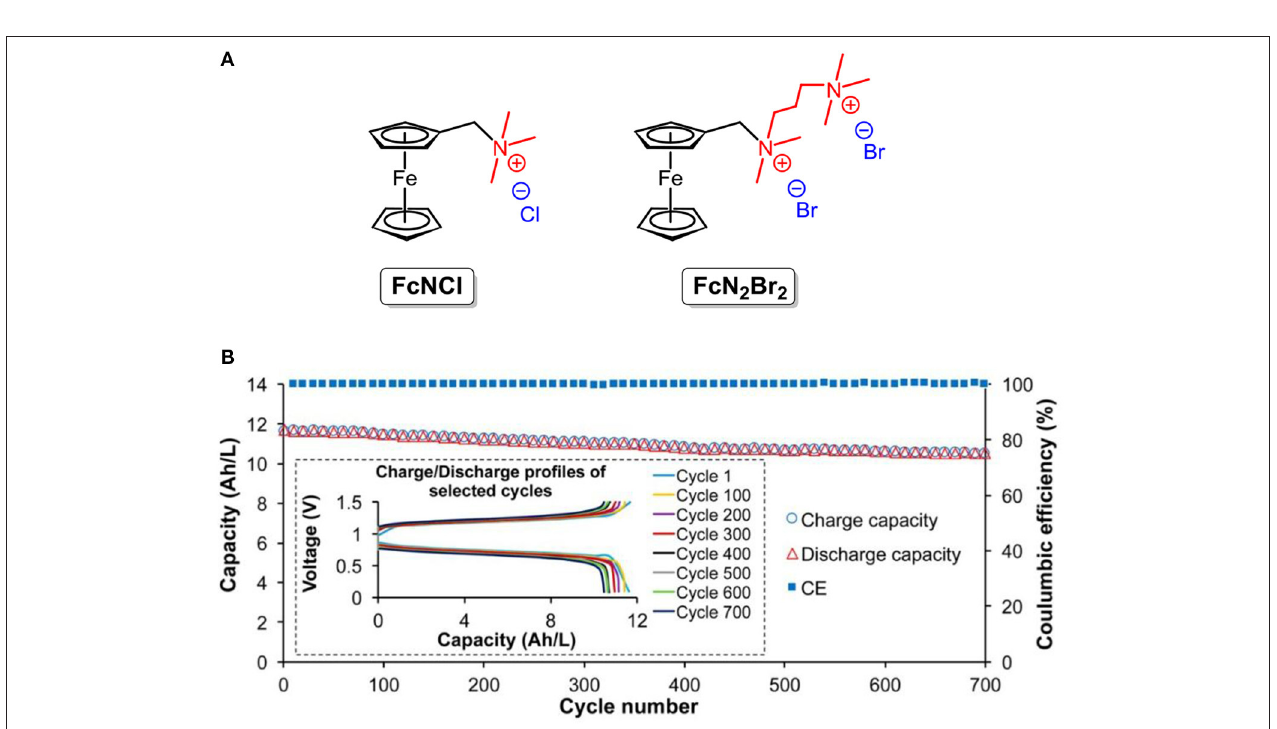
FIGURE 9 | (A) Molecular structures of FcNCl and FcN 2 Br 2 . (B) Extended 700 cycle testing data of the 0.5M FcNCl / MV aqueous RFB at 60 mA/cm 2 : capacity and coulombic efficiency vs. cycling numbers (for clarity, data points with an increment of 10 cycles were used for plotting) (inset) representative charge and discharge profiles of selected cycles. Reproduced with permission from Hu et al. (2017). Copyright 2017, American Chemical